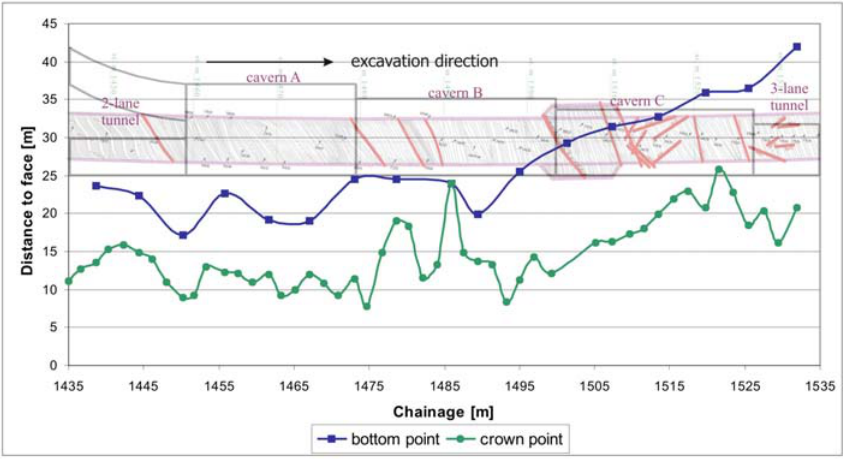
Figure 13. Extension of the influence area ahead of the face for crown and bottom